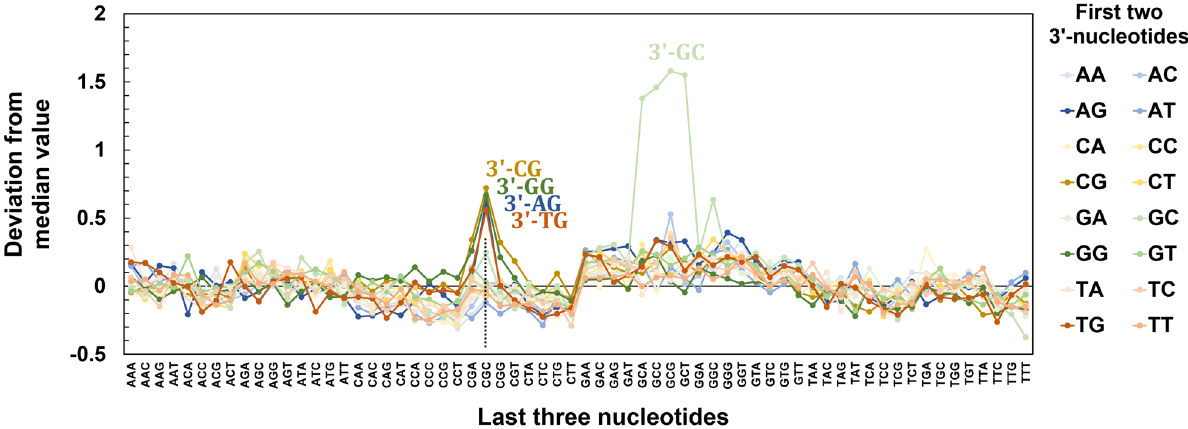
Figure 4. Influence on fluorescence intensity, expressed as deviation from mean fluorescence, of each X 3 X 4 X 5 trinucleotide combination over each possible X 1 X 2 dinucleotide in 3 ʹ Cy3-labeled X 1 X 2 X 3 X 4 X 5 pentamers. Mean values are corrected for background fluorescence then standardized across the entire range of Cy3 fluorescence signals. Large deviations are seen for all possible 3 ʹ -XGCGC and 3 ʹ -GCGXX